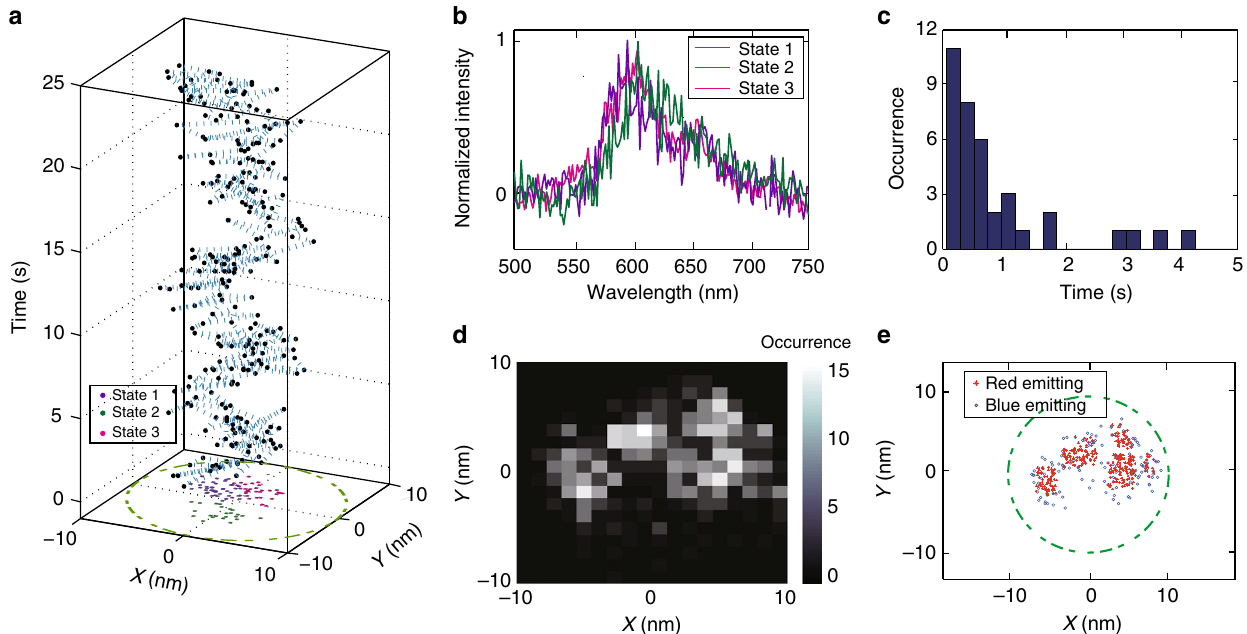
Fig. 5 Superresolution mapping of the energy landscape inside a CPN. a The polaron position trajectory obtained during an intensity off segment, at 50 Hz framerate, showing a total of 3 distinguishable states. For this plot, every 5 points in the position trajectory were binned together to reduce noise. b The spectra of the three states shown in plot a . c Polaron hopping time histogram, determined from the change point analysis. d Polaron position histogram constructed from multiple polaron hopping trajectories and e the corresponding 2D scatter plot. The red and blue dots indicate the areas that exhibit red and blue emission,